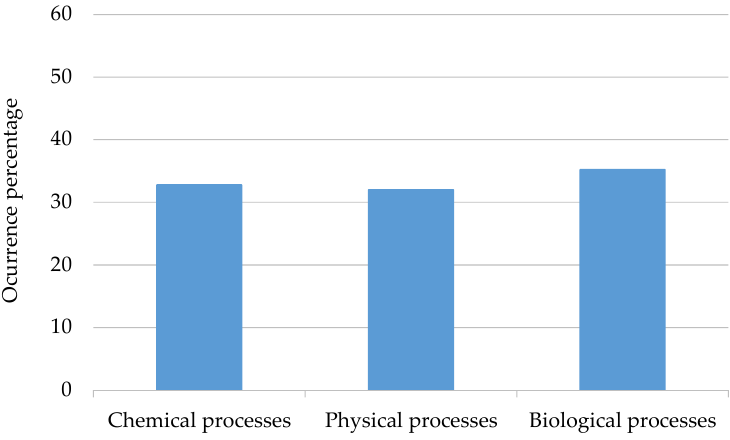
Figure 7. Treatment processes of wastewater containing pharmaceuticals.